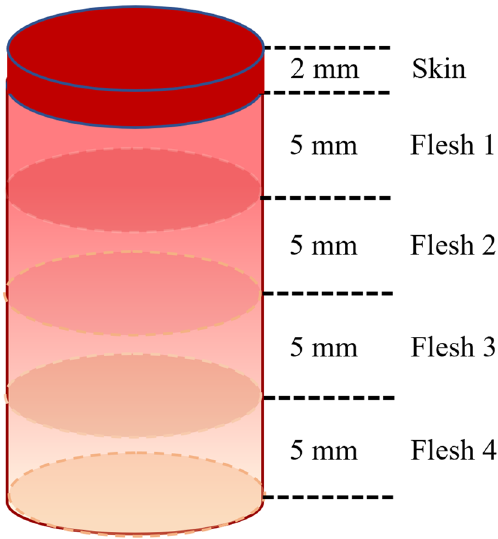
Figure 12. Graphical illustration of skin and fleshes at different depths used for anthocyanin